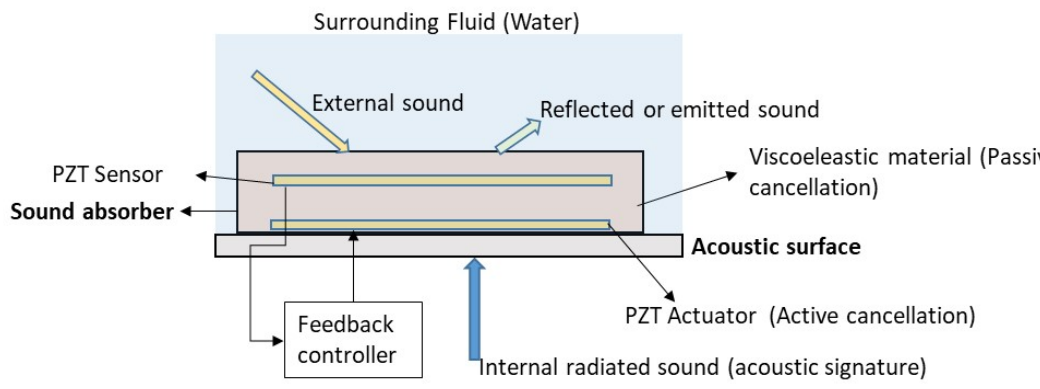
Figure 5. External, internal and reflected sound in an acoustic surface. Active/passive sound cancellation